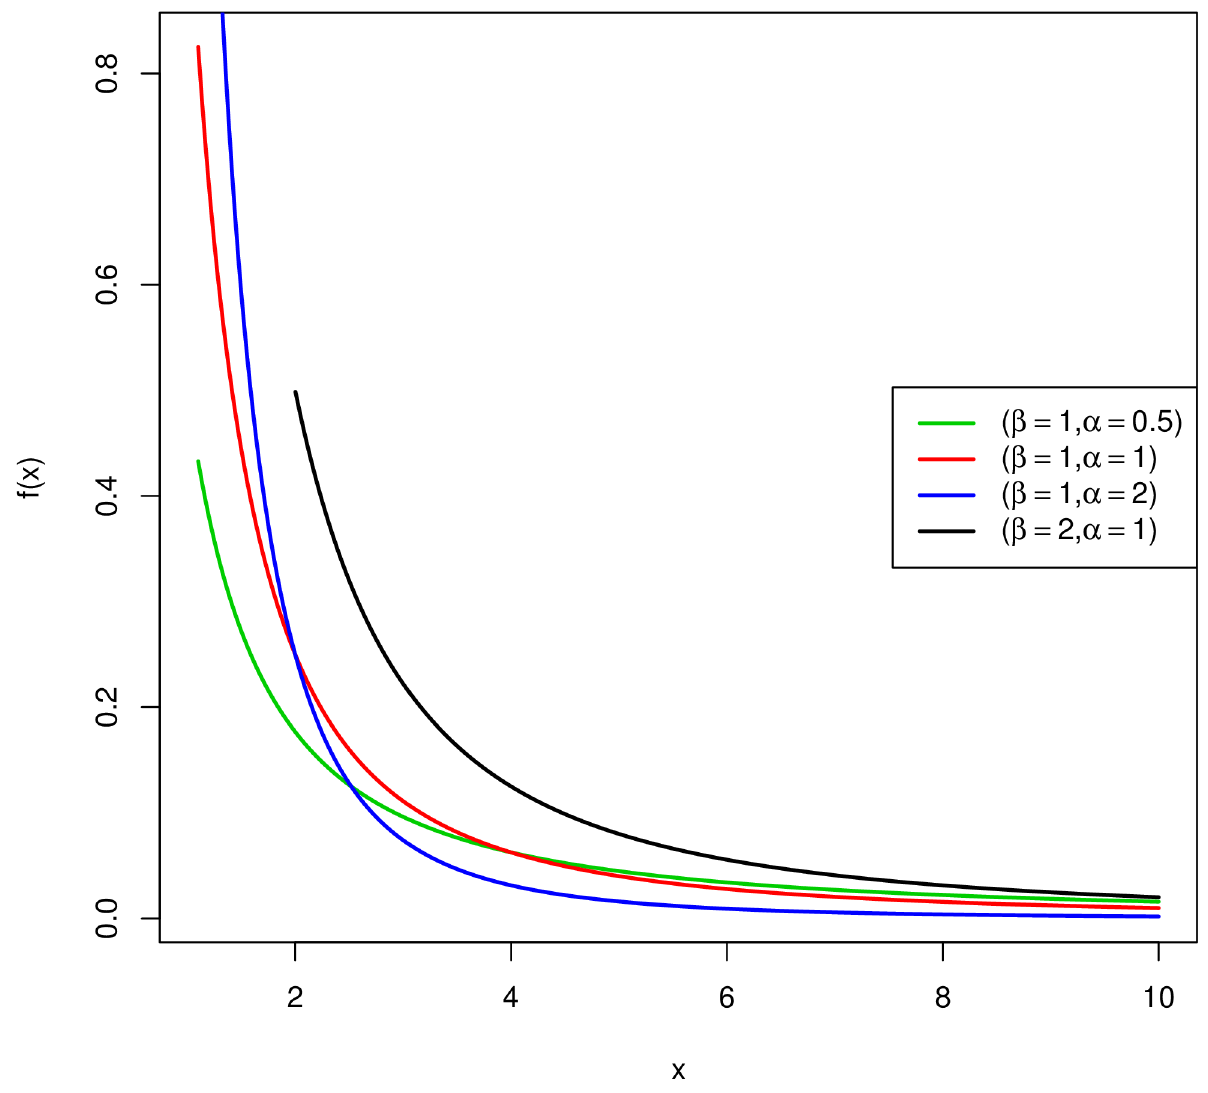
Fig 1. PDF of the Pareto distribution.